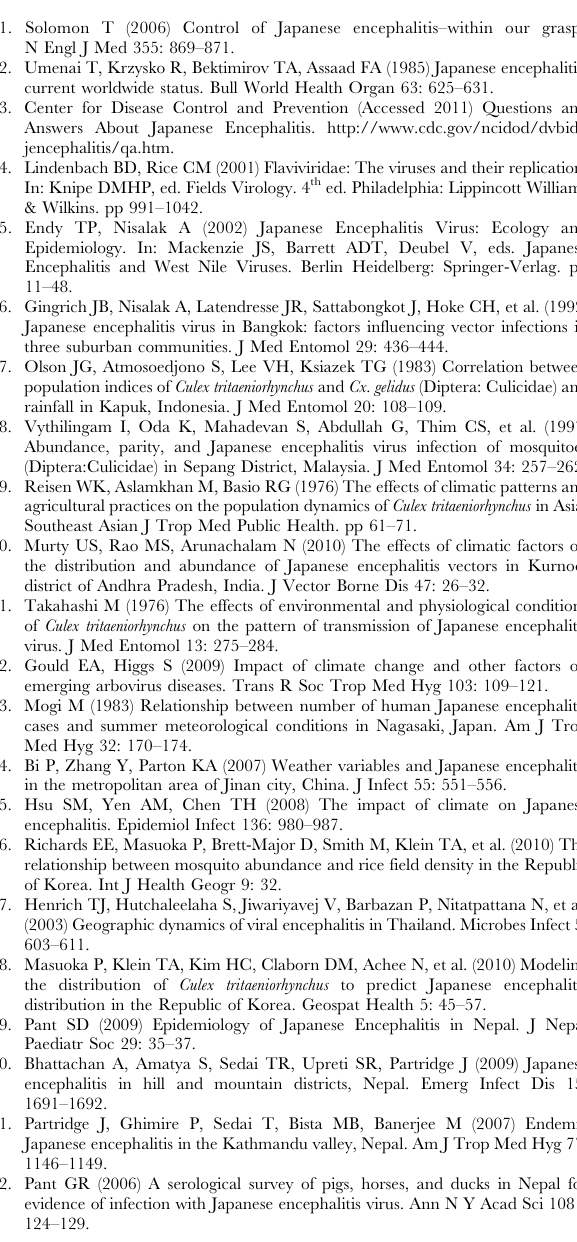
Figure S3 Predicted smoothed JE incidence (A) and prediction error (B) for the 2005 dataset using the parsimonious model. The prediction error was calculated as the observed 2005 JE incidence (see Figure 2 in main text) minus the 2005 predicted smoothed JE incidence. The negative values in the prediction error represent overestimation of the model while the positive values represent underestimation of the model. The values were back-transformed from the model using the equation ( 2 1/(y i 2 1)) 2 1 to retrieve the predicted JE incidence. (TIF) Table S1 Pearson’s correlation coefficient matrix of variables used in the full model for 2005 JE